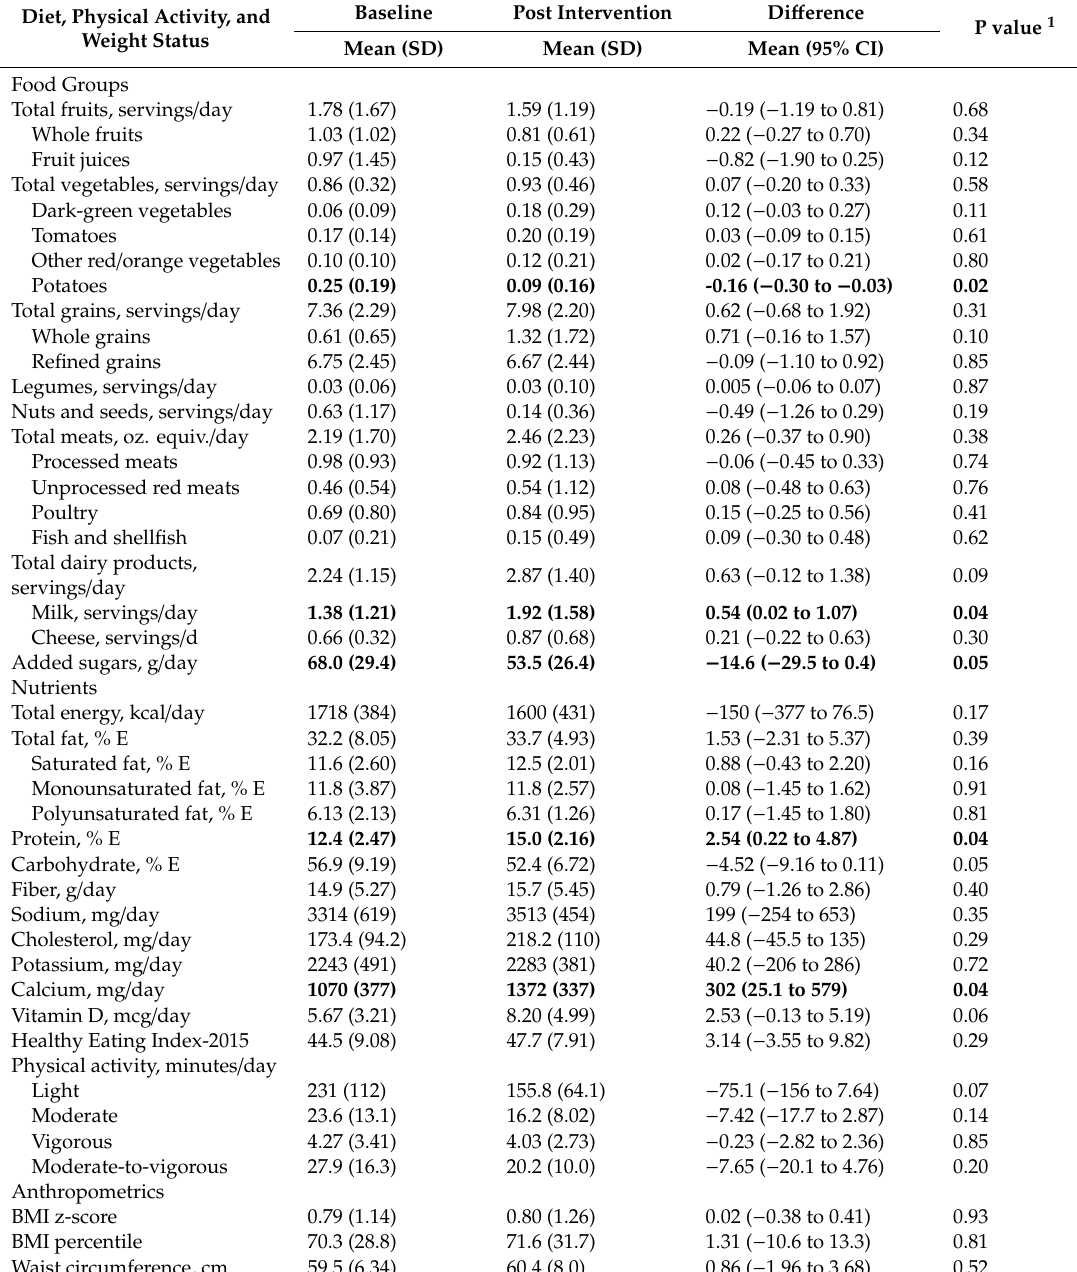
Table 2. Changes in diet, physical activity, and weight status in pediatric patients of acute lymphoblastic leukemia (ALL), the Healthy Eating and Active Living (HEAL) pilot